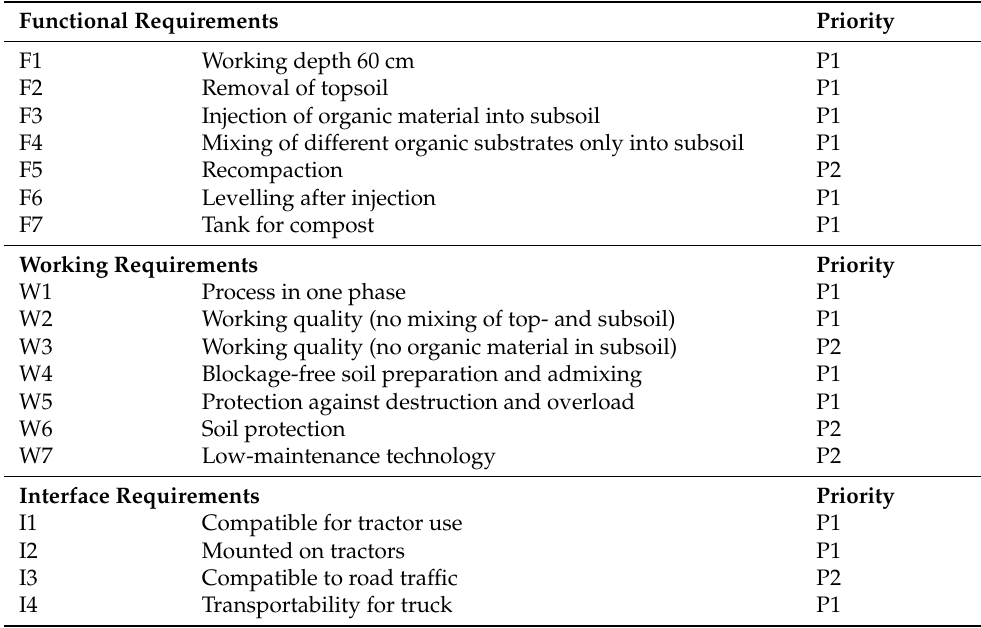
Table 1. Requirements for the design of the Soil 3 -melioration technology.